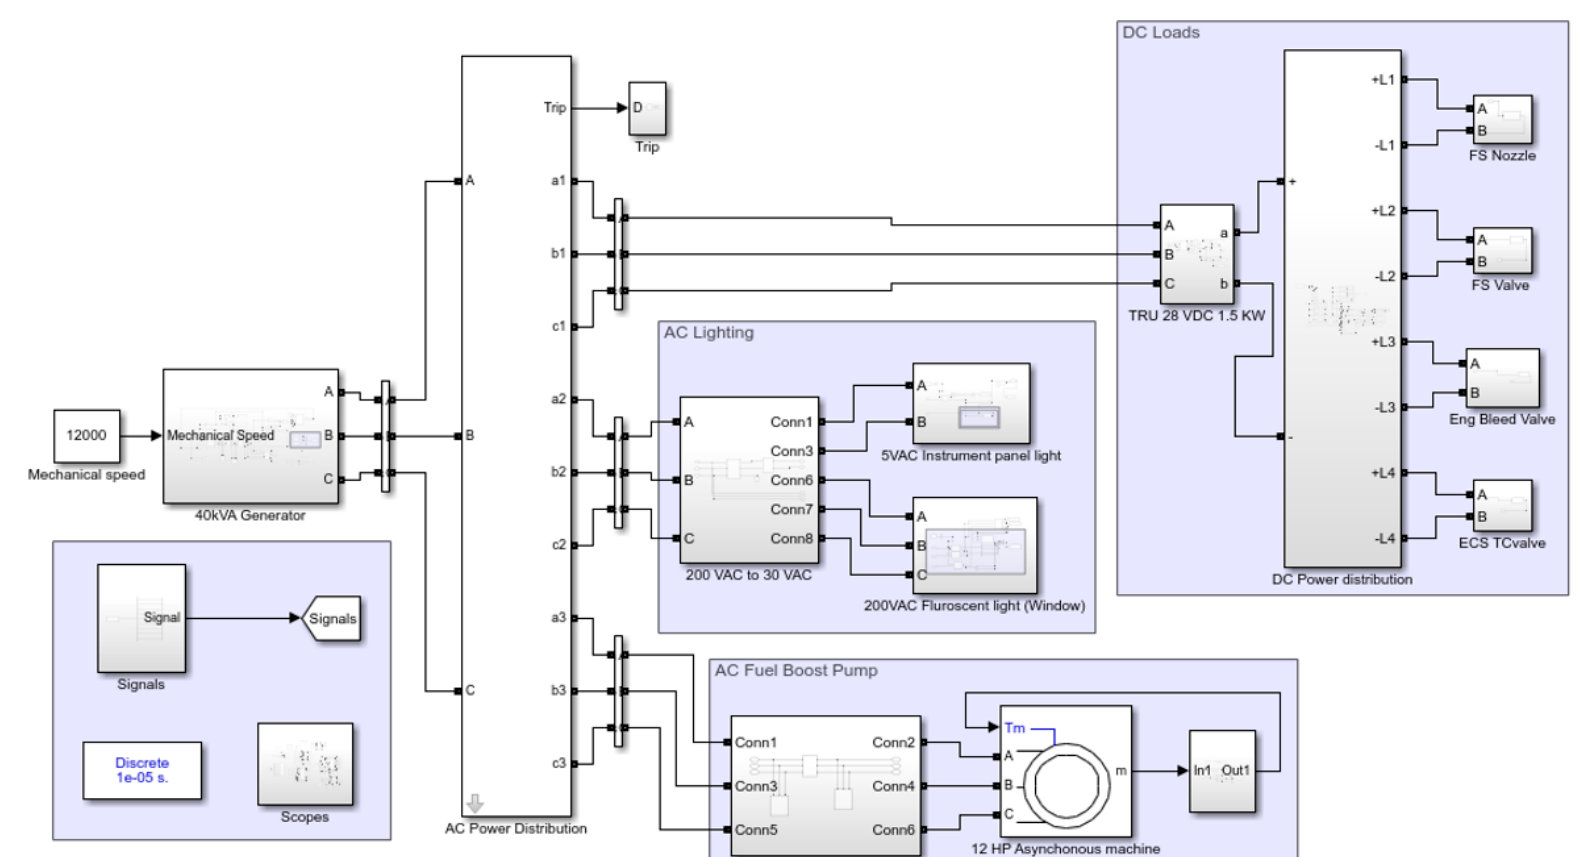
Figure 1. MATLAB-Simulink model for the aircraft Electrical Power System (EPS).